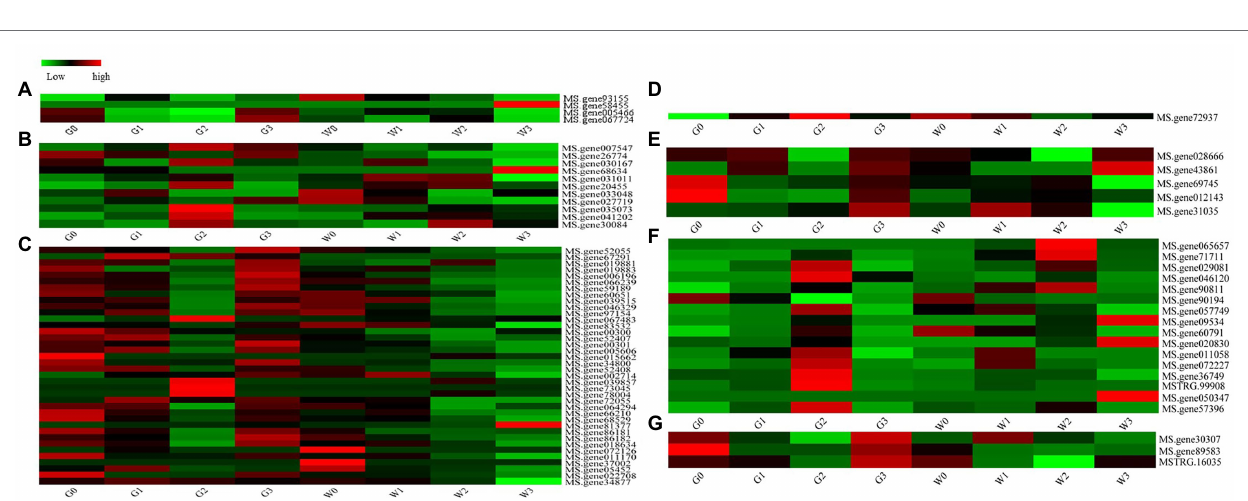
FIGURE 8 | Heat maps of the ATP-binding cassette (ABC) family genes in the alfalfas from RNA-seq. (A) ABC Subfamily A, (B) ABC Subfamily B, (C) ABC Subfamily C, (D) ABC Subfamily E, (E) ABC Subfamily F, (F) ABC Subfamily G, and (G) ABC Subfamily I.